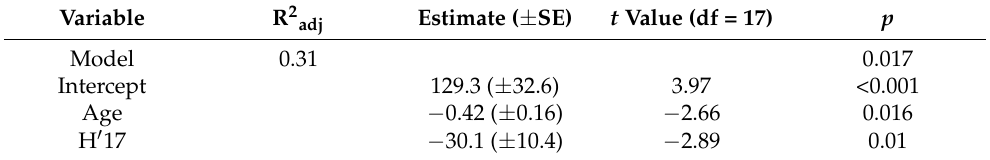
Table 5. Outputs of the best model explaining changes in occurrence for species with the largest gains ( N = 24) in relation to time since last disturbance (Age) and Shannon–Wiener index of the understory plant community diversity in 2017 (H (cid:48) 17). The adjusted coefficient of determination (R 2 adj ) and the p -value of the best model are shown, as well as the estimate ( ± standard error), the Student’s t value and the p -value of each